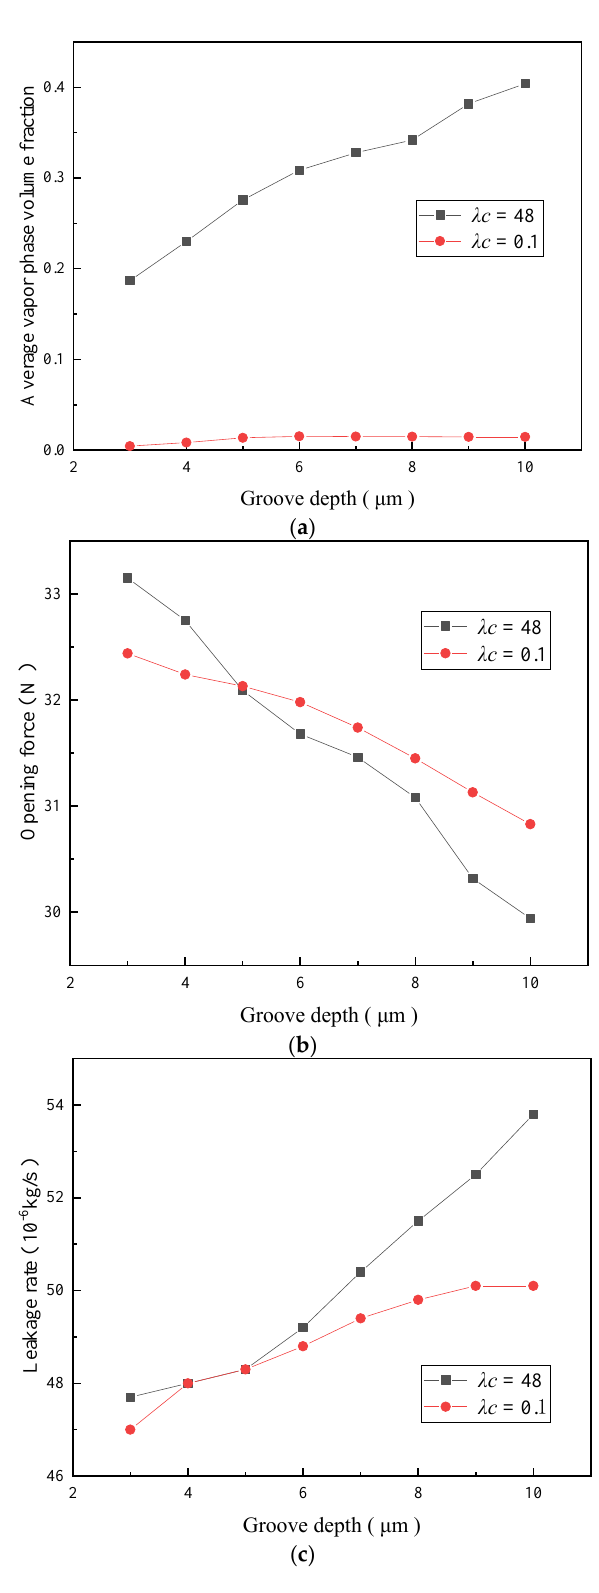
Figure 8. Effect of groove depth on sealing performance. ( a ) Effect on the average vapor phase volume fraction. ( b ) Effect on the opening force. ( c ) Effect on leakage